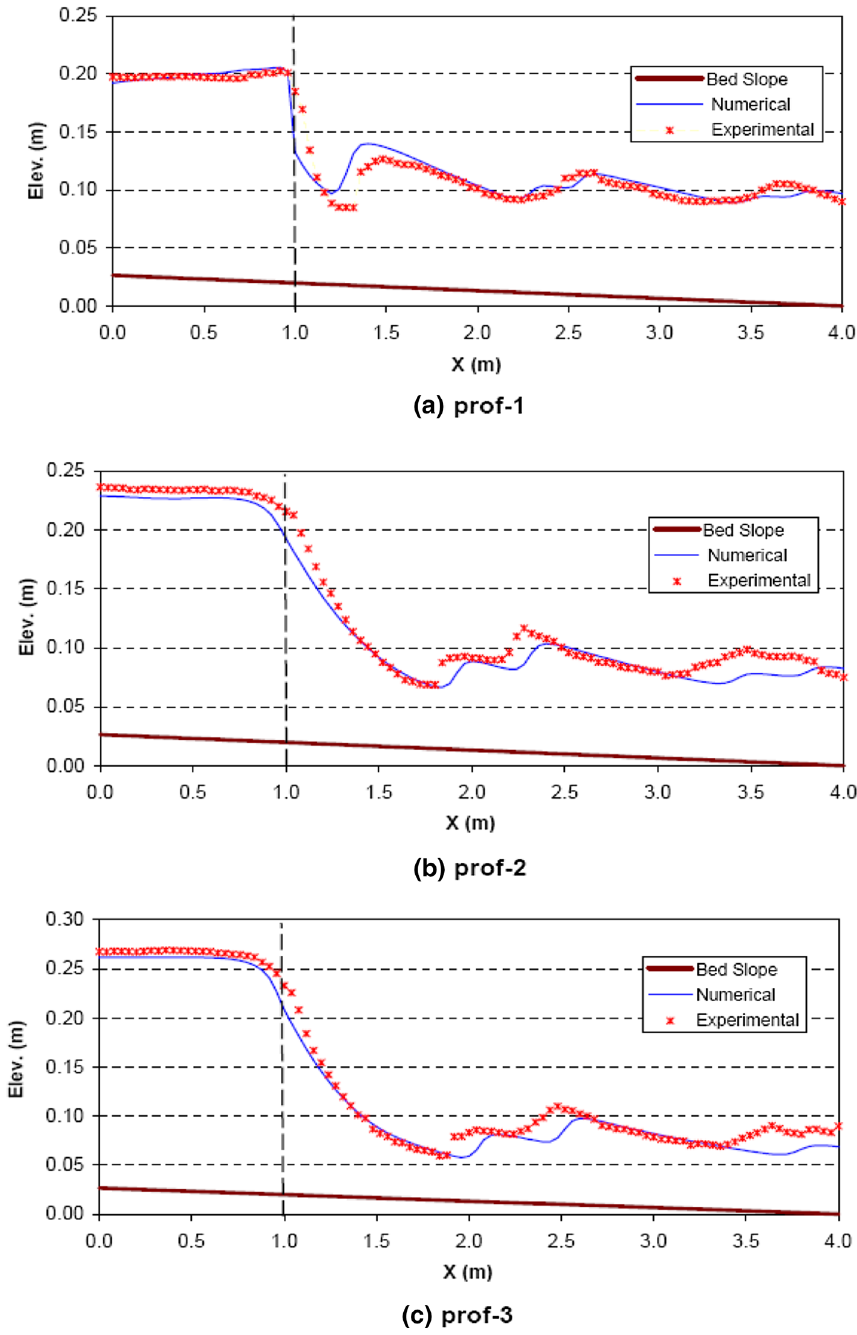
Fig. 7 The longitudinal profiles of flow depths in numerical and experimental